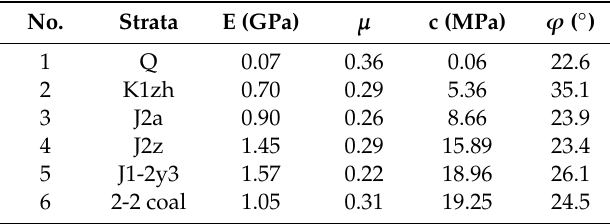
Table 2. Initial mechanical parameters of overlying strata.